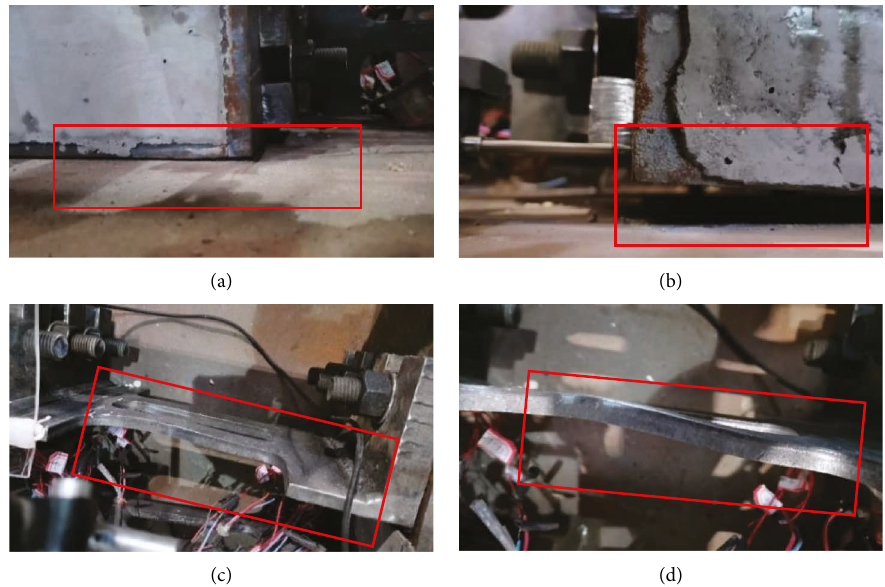
Figure 11: The deformation of RED during testing. (a) Rocking stage. (b) Uplift of the HRC bottom. (c) The initial deformation of RED. (d) The obvious deformation of